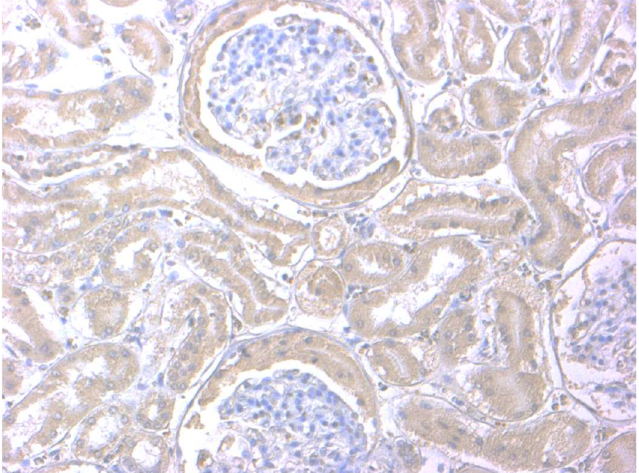
Figure 1. Liver of a dog after PIVKA-II immunostaining. Positive diffuse cytoplasmic immunoreactivity within hepatocytes. PIVKA-II immunohistochemistry, Mayer’s hematoxylin counterstain, and 40× objectives.